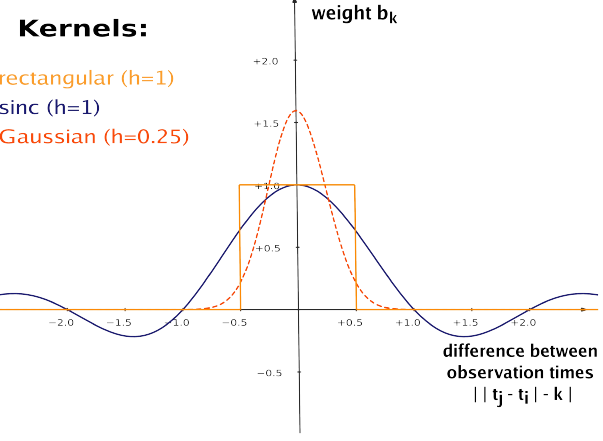
Fig. 2. Kernel-based estimators effectively “use” observations whose inter-sampling time difference is close to the lag for which linear correlation is estimated. Slotting (the rectangular kernel) chooses observations within an interval, Gaussian and sinc kernel weigh the products smoothly according to the difference between observation interval and desired lag. Kernels were scaled to the standard choice for width parameter h (cf. Table 1, Fig. 3).